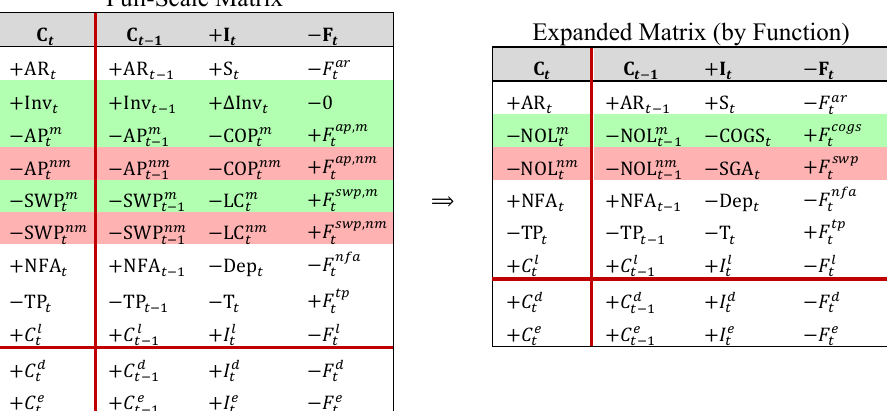
Figure 26. From full-scale Matrix to expanded Matrix by function (see Part I, Equation (36)). The rows with the same color in the Full-scale Matrix are consolidated into one row of the same color in the Expanded